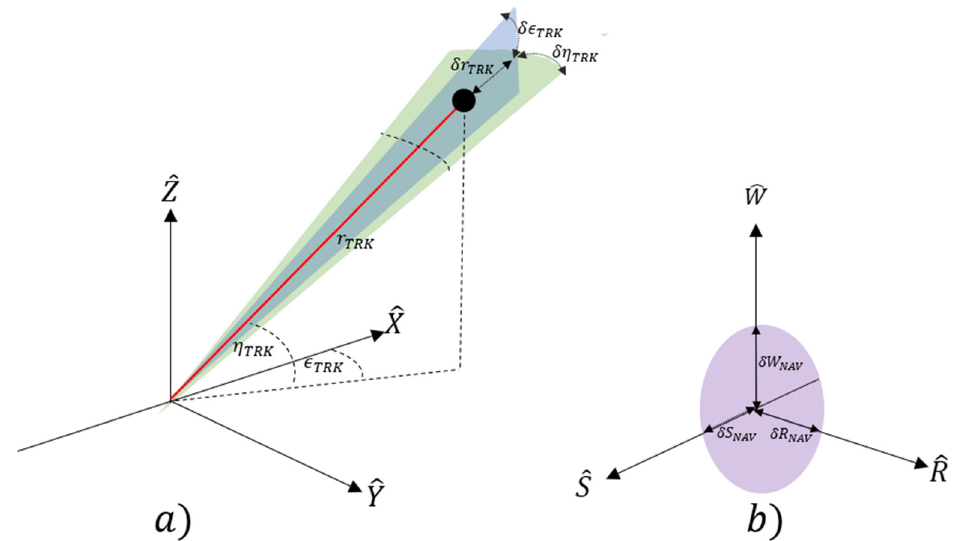
Figure 2. Generic Tracking ( a ) and Navigation ( b ) RSW coordinate systems detailing corresponding error geometry.